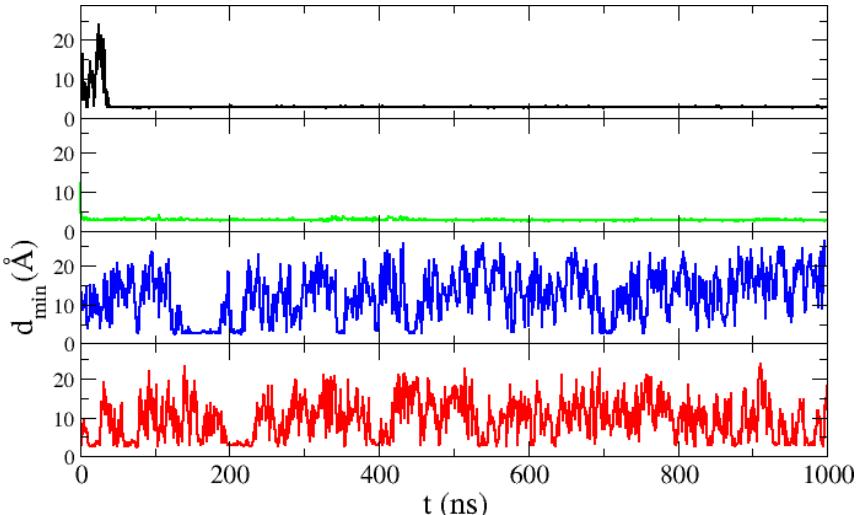
Figure 8. Minimum distance between two ACTR molecules in molecular dynamics simulations of a solution of ACTR at a concentration of 10 mM with the TIP3P (black line), SPC/E (green), TIP4P-EW (blue) and TIP4P/2005 (red) water